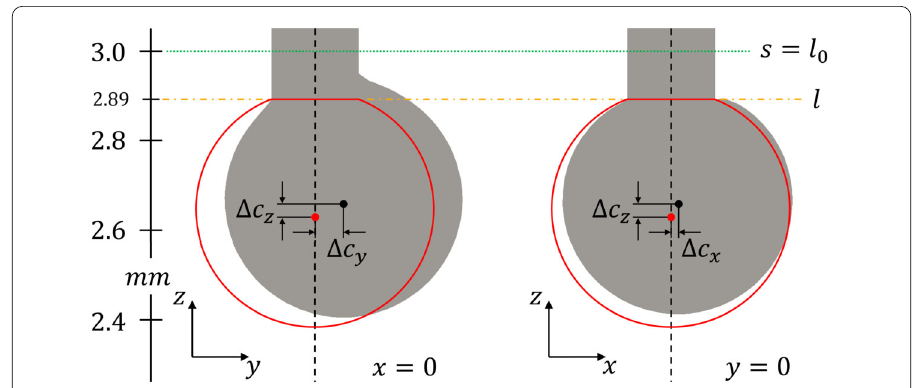
Figure 6 Final preform shape (Run 12): The 3 d preform shape and its barycenter ( • ) below l are compared to a centered fictional sphere segment of the same volume with corresponding barycenter ( • ). For visualization, 2 d cross sections with componont-wise barycenter distance (cid:2) c = ( (cid:2) c x , (cid:2) c y , (cid:2) c z ) T are